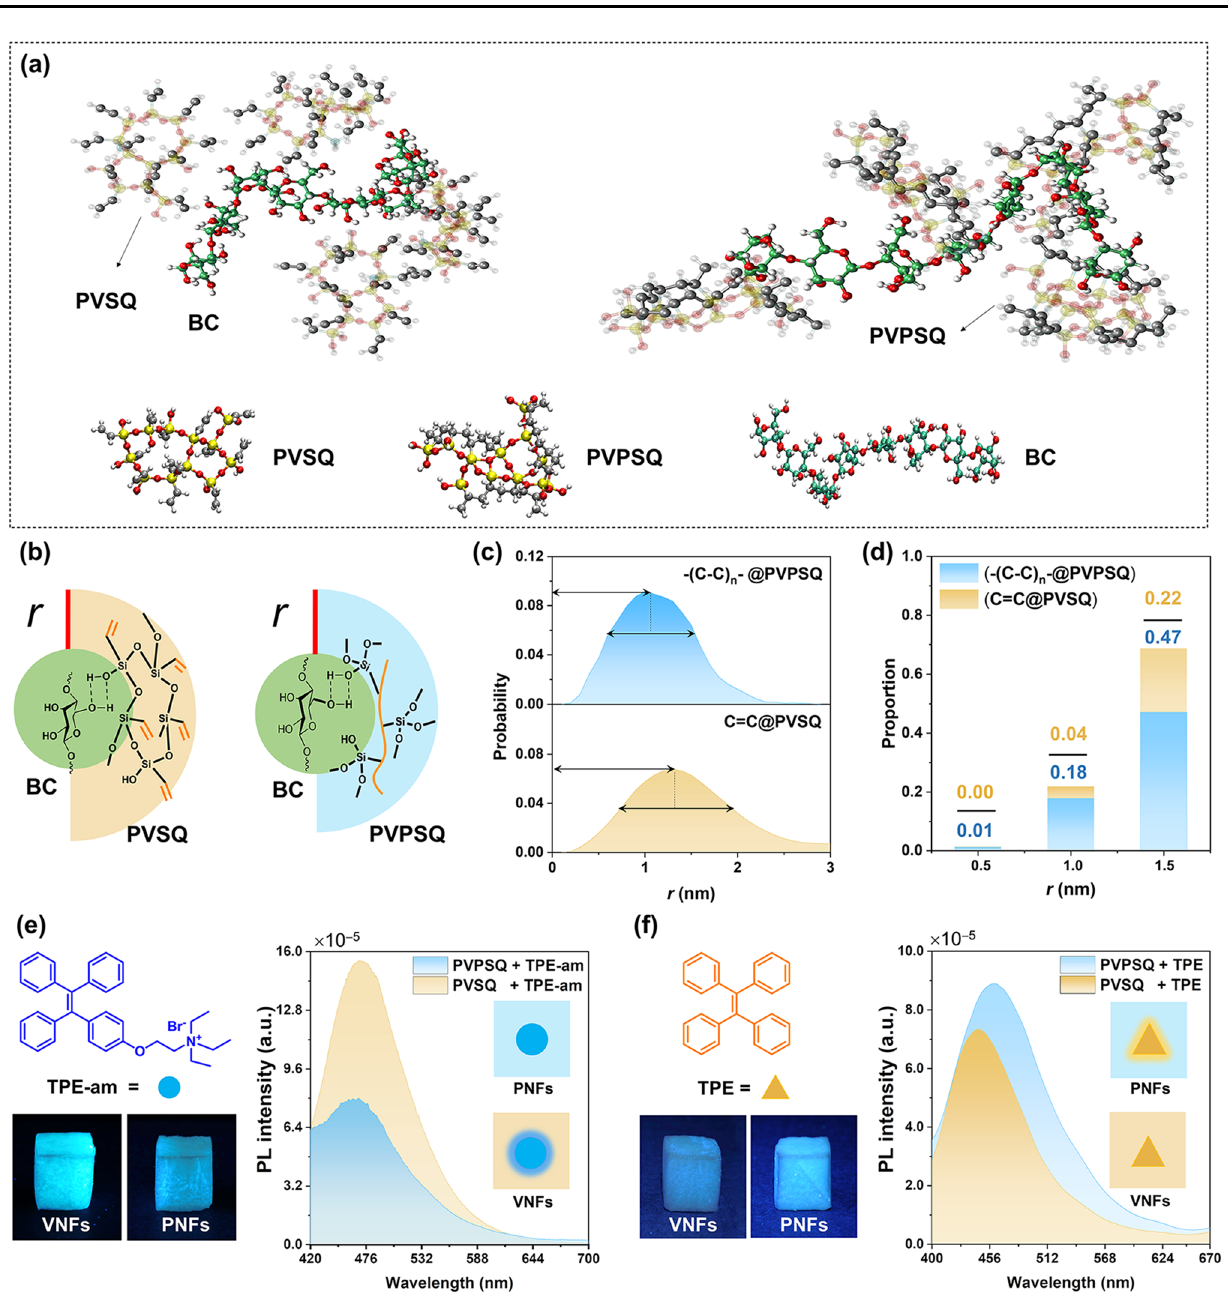
Fig. 3 Mechanism analysis and visualization of tunable wettability. a A snapshot of molecular dynamics simulation of interactions between PVSQ/PVPSQ and BC nanofibers. b Molecular orientations of polysiloxane on the surface of BC nanofibers. The radial distance between the carbon atoms of PVSQ/PVPSQ and BC nanofibers is denoted as r . c The distribution of radial distances ( r ) between the carbon atoms of PVSQ/ PVPSQ and BC nanofibers. d Proportion of carbon atoms for PVSQ and PVPSQ when r is 0.5 nm, 1.0 nm, and 1.5 nm, respectively. e−f AIE- doped aerogels to visualize the internal and integral wettability of the aerogels. Fluorescence images and spectra were taken under UV irradia-